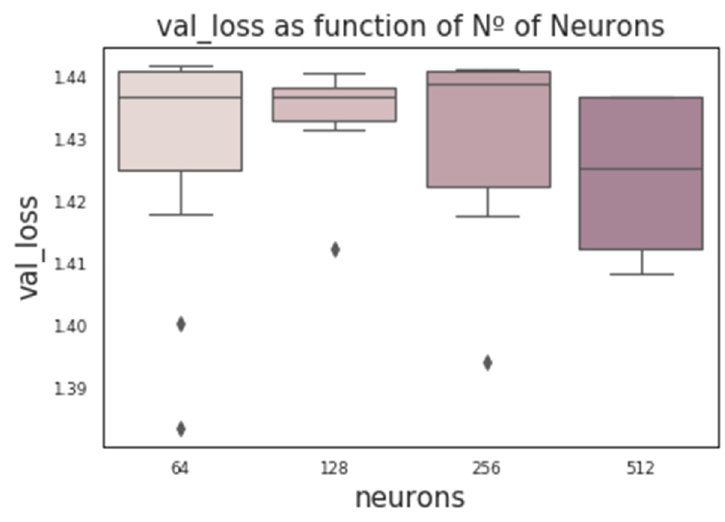
Figure 7. Box-plot representing the loss in the validation set vs. the number of neurons using RNN architecture.